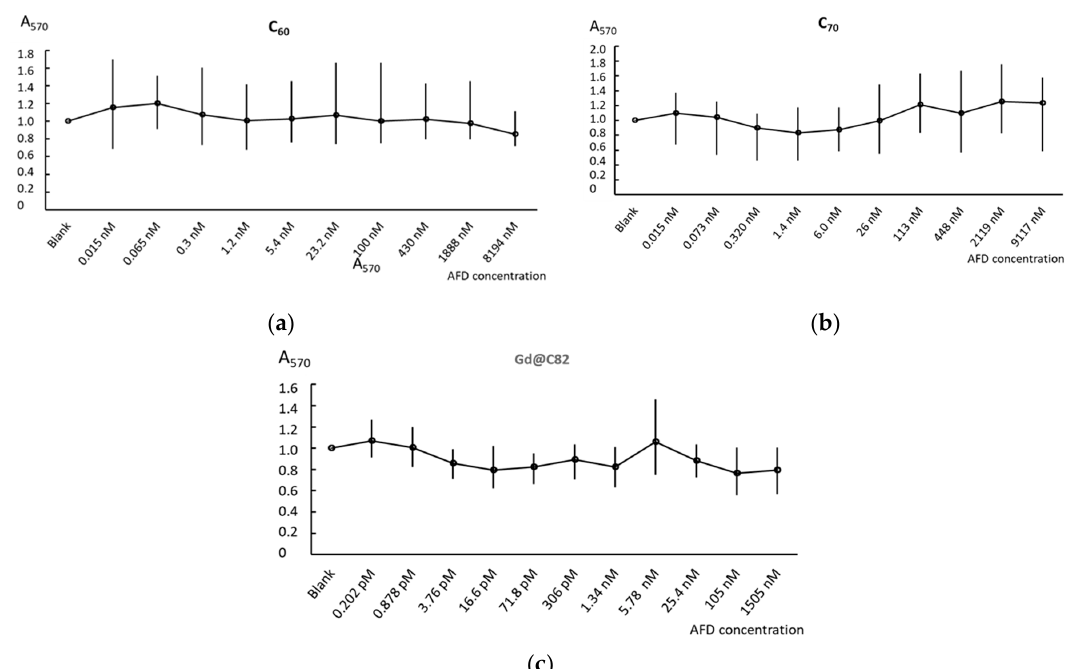
Figure 2. The MTT test: cell viability in versus concentrations of C 60 ( a ), C 70 ( b ), and Gd@C 82 ( c ) after 72 h of incubation. In blank experiments, cells were incubated without the AFDs.